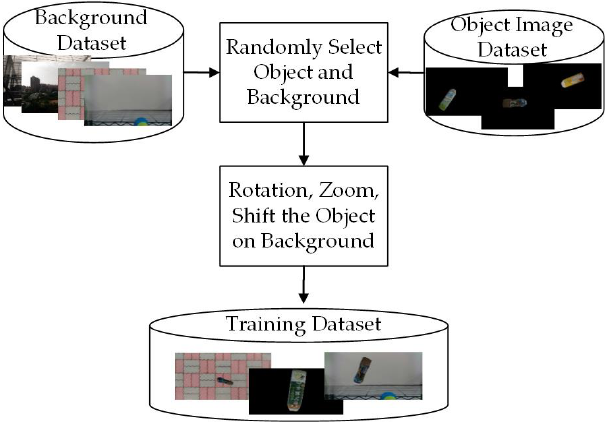
Figure 5. Procedure of the proposed data augmentation